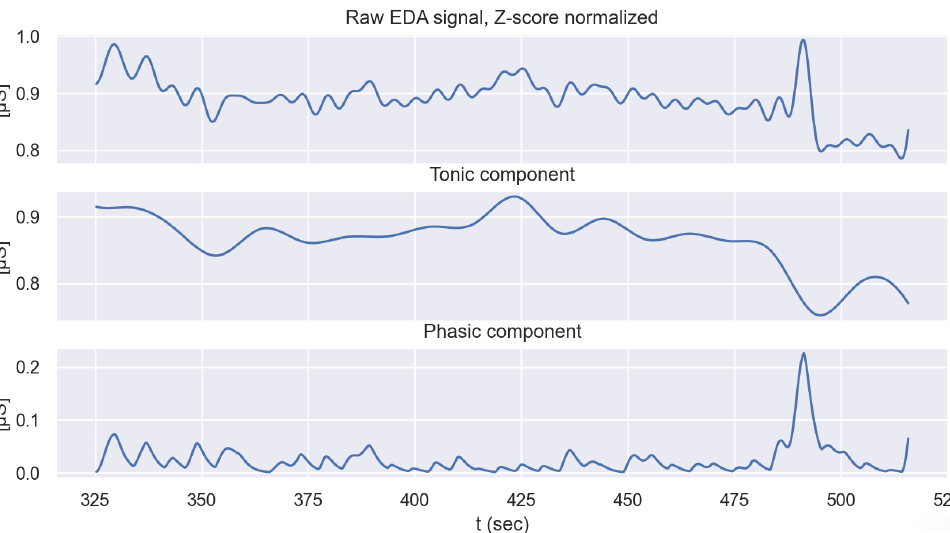
Figure 5. Example of decomposed tonic and phasic components from raw EDA signal using the Convex Optimization method.